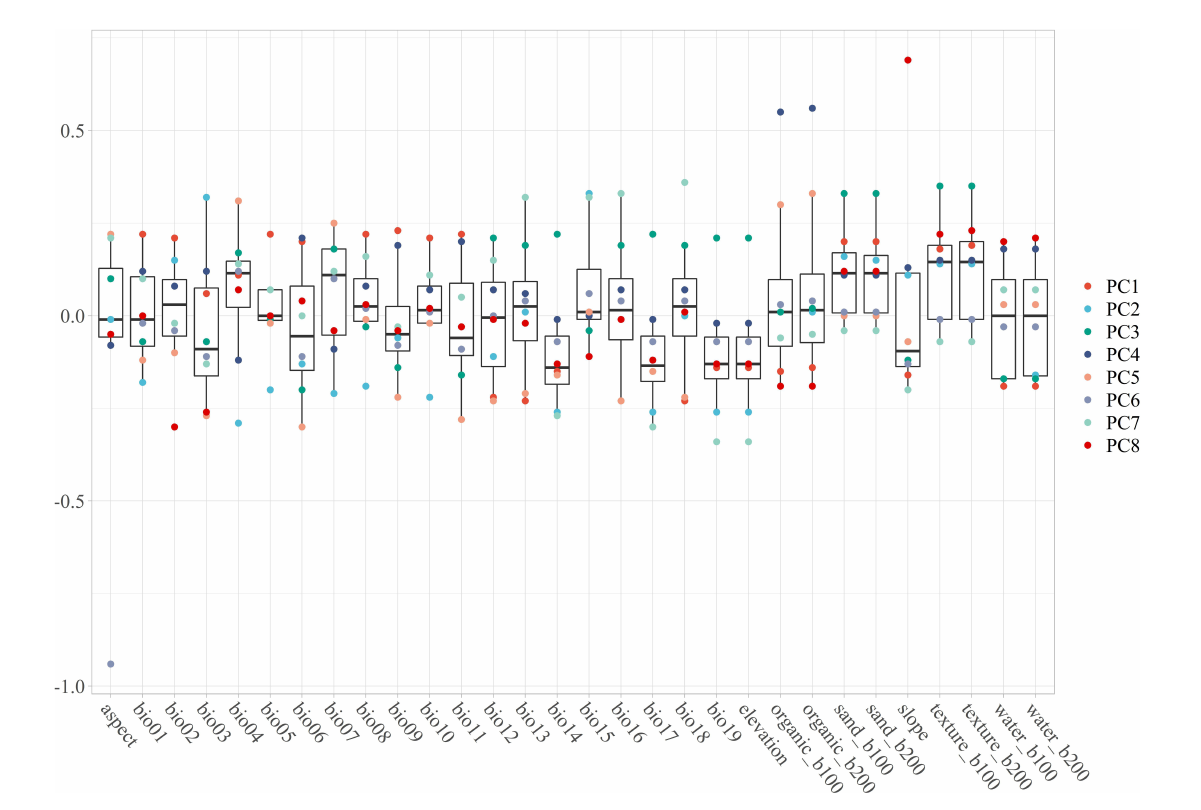
FIGURE1 The PC1 to PC8 are containing with the main information of environmental variables. The main feature of each variable can be contained in one or more PCA, especially the outlier should pay more attention. The PC1 contains the features of bio01, bio05, bio06, bio09, bio11, bio13, and bio16; The PC2 contains the features of bio01, bio03, bio04, bio05, bio07, bio08, bio10, bio14, and bio15; The PC3 contains the features of bio12, bio14, bio17, bio19, elevation, sand_b100, sand_b200, texture_b100, and texture_b200; The PC4 contains the features of bio06, bio09, bio11, organic_b100, and organic_b200; The PC5 contains the features of bio03, bio04, bio06, bio09, bio11, bio12, bio13, bio16, bio18, organic_b100, and organic_b200; The PC6 contains the feature of aspect; The PC7 contains the features of bio13, bio14, bio15, bio16, bio17, bio18, bio19, and elevation; The PC8 contains the features of bio02, bio05, bio15, organic_b100, organic_b200, slope, water_b100, and